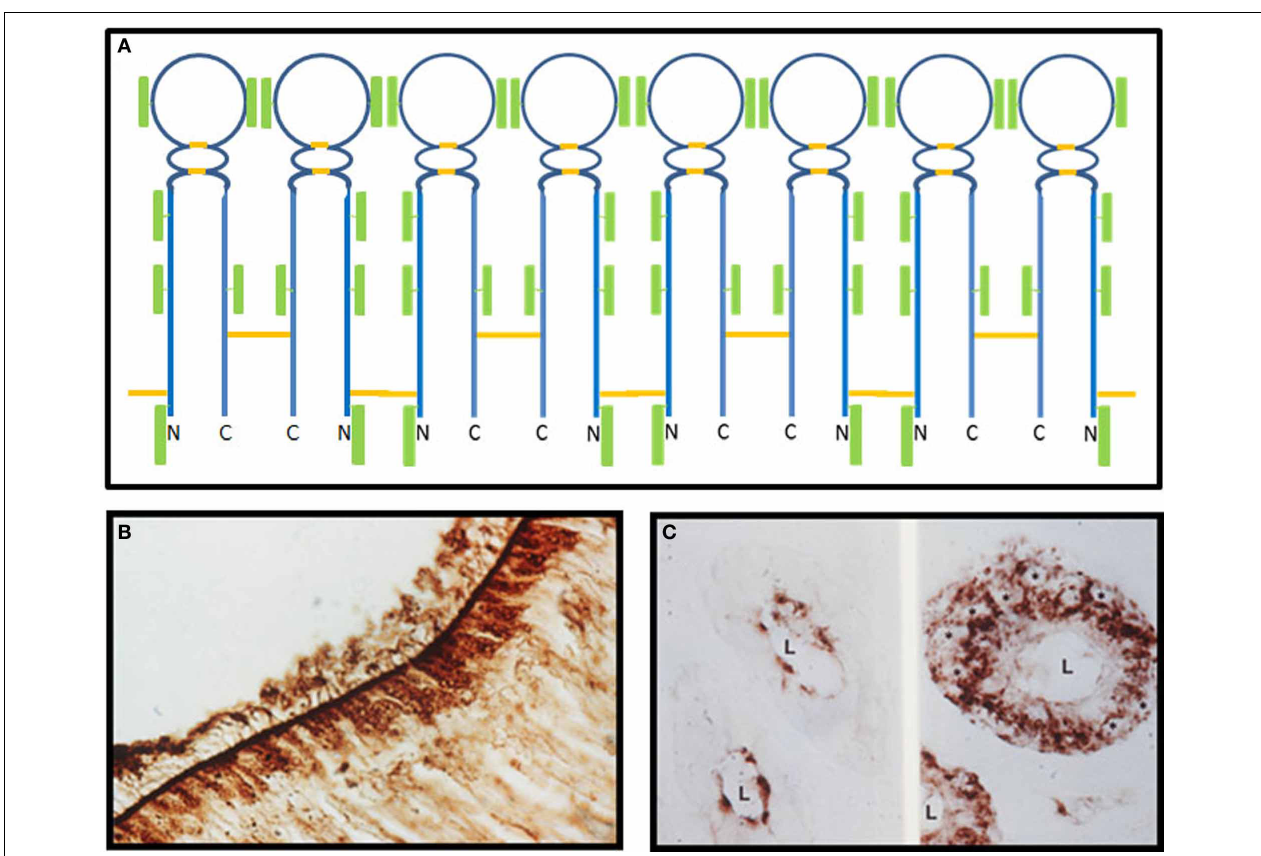
FIGURE 1 | Olfactomedin from the bullfrog. (A) A model for the structure of olfactomedin based on biochemical and immunochemical studies. There are six N-glycosylated carbohydrate attachment sites, two internal disulfide bonds, and two cysteines, including the CXC motif near the N-terminus that can form intermolecular disulfides, which mediate the formation of oligomers through alternating single and double disulfide bonds. Disulfide bonds are shown in orange and the green rectangular boxes represent carbohydrate moieties (modified from Yokoe and Anholt, 1993). (B) Immunohistochemical localization of olfactomedin at the surface of the olfactory neuroepithelium of Rana catesbeiana . Granular staining of brown horseradish peroxidase